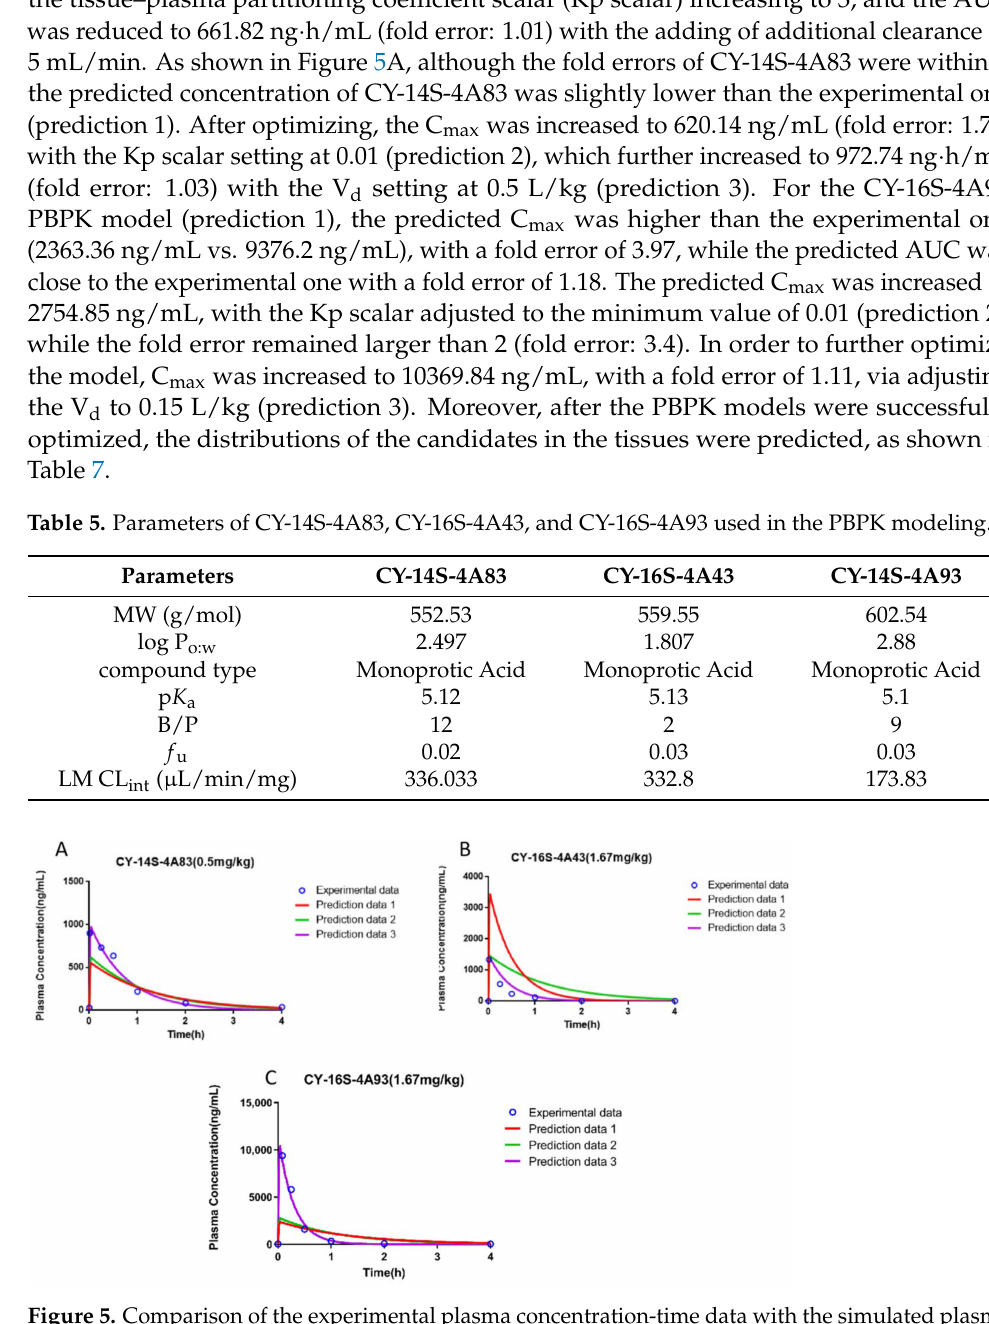
Figure 5. Comparison of the experimental plasma concentration-time data with the simulated plasma concentration-time profile of CY-14S-4A83 ( A ) with Kp scalar of 1 (prediction 1), Kp scalar of 0.01 (prediction 2), and Vd of 0.5 L/kg (prediction 3); CY-16S-4A43 ( B ) with Kp scalar of 1 (prediction 1), Kp scalar of 3 (prediction 2), and the added additional clearance of 5 mL/min (prediction 3); and CY-16S-4A93 ( C ) with Kp scalar of 1 (prediction 1), Kp scalar of 0.01 (prediction 2), and Vd of 0.15 L/kg (prediction